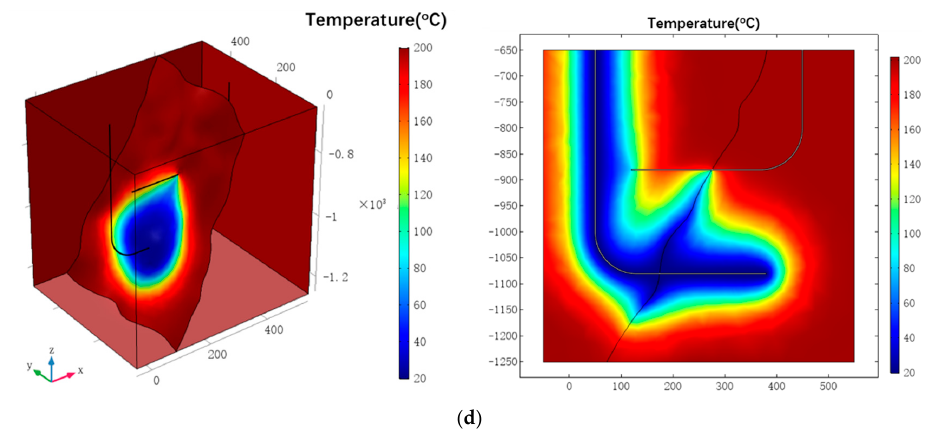
Figure 5. Temperature distribution in fracture surface and y = 250 m surface at different times; ( a ) t = 1a; ( b ) t = 15a; ( c ) t = 30a; ( d ) t = 45a.